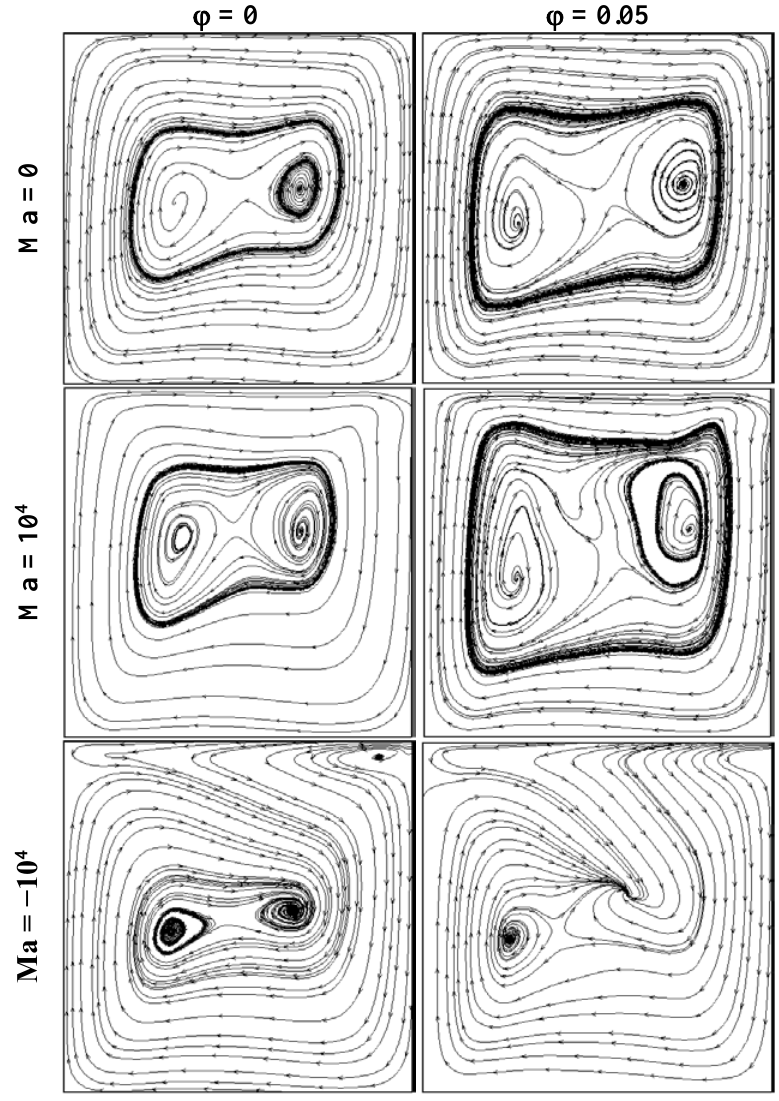
Figure 3. Velocity vectors projection on the central plan for Ra = 10 5 , (Ha = 0) and different Ma.